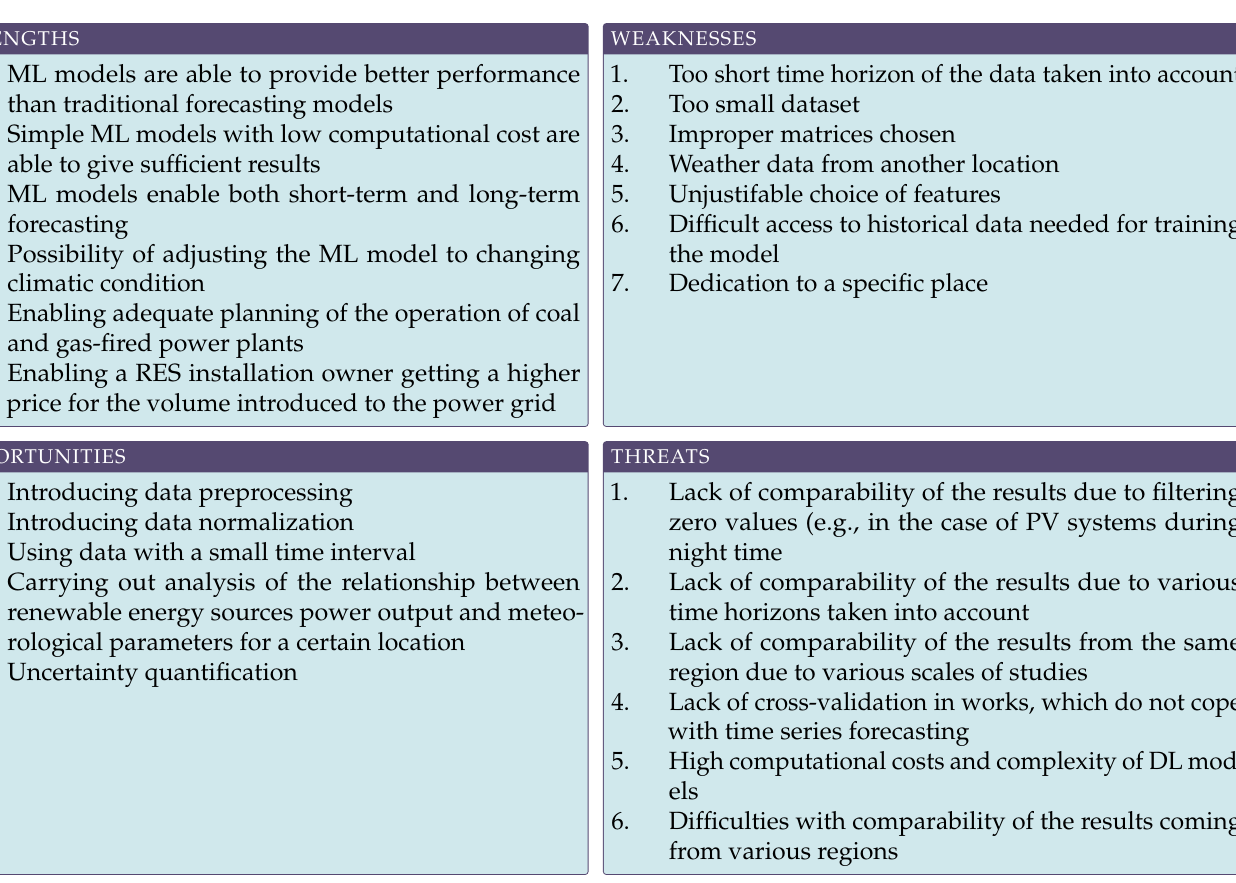
Table 4. SWOT analysis for papers concerning ML applications for prediction of energy generation from